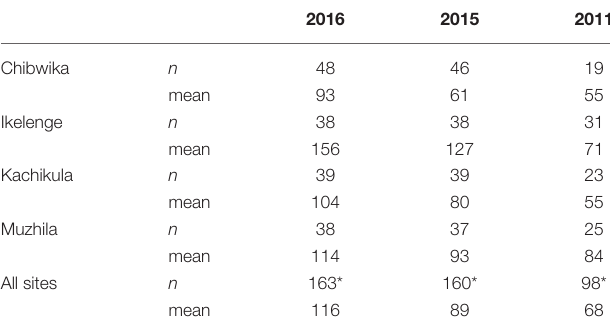
TABLE 5 | Average hive ownership and no. of beekeepers who had hives at each